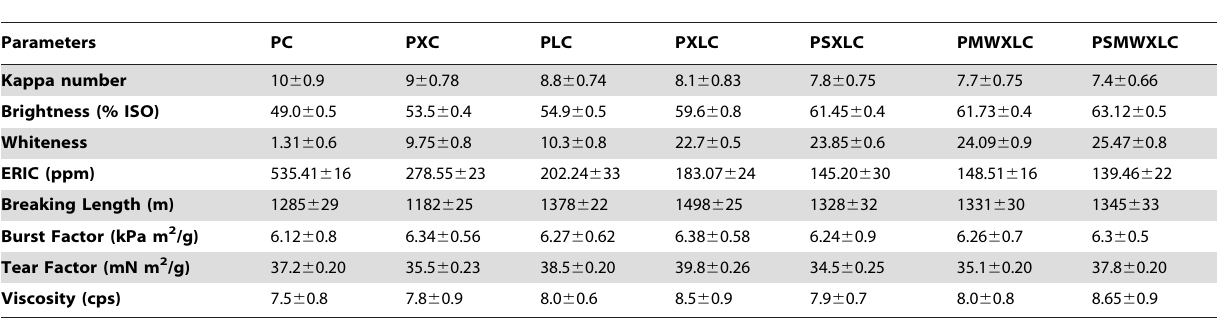
Table 1. Physical and Chemical characterization of enzymatically and physically deinked pulp.